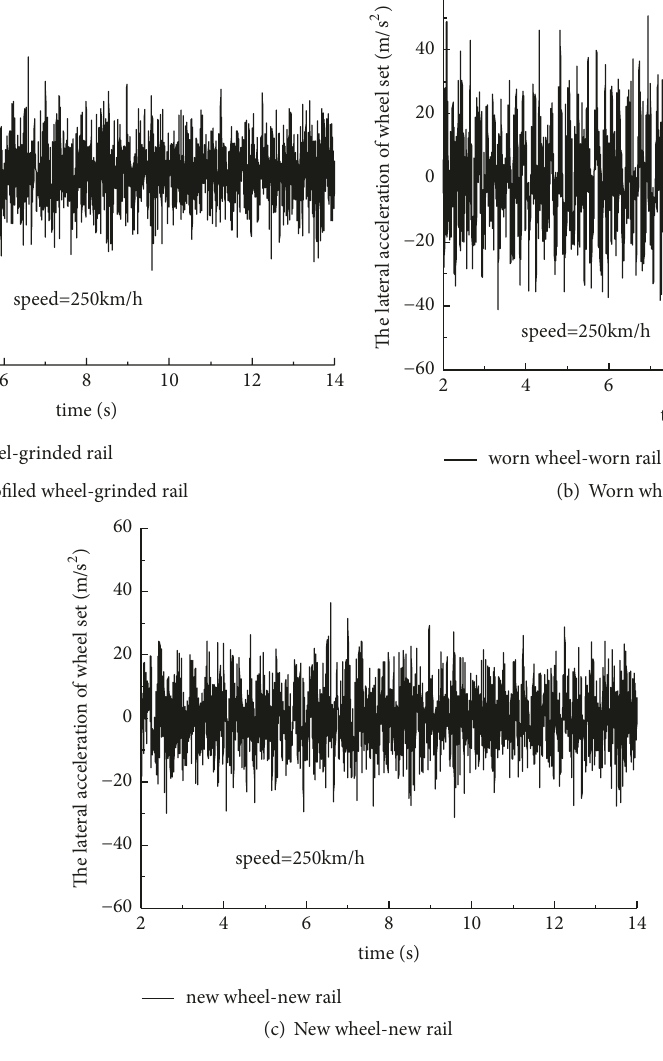
Figure 14: The lateral acceleration of wheel